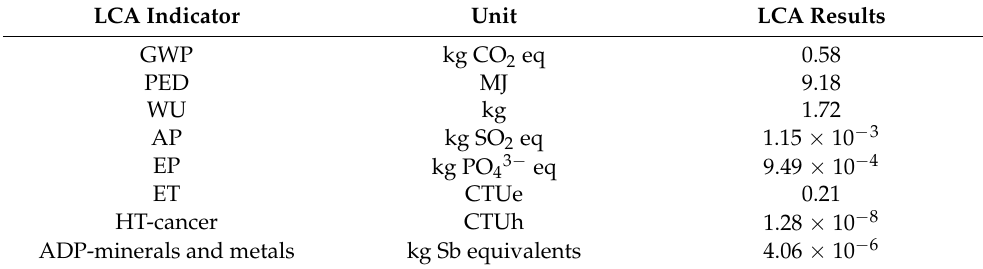
Table 5. Results for scenario 3.